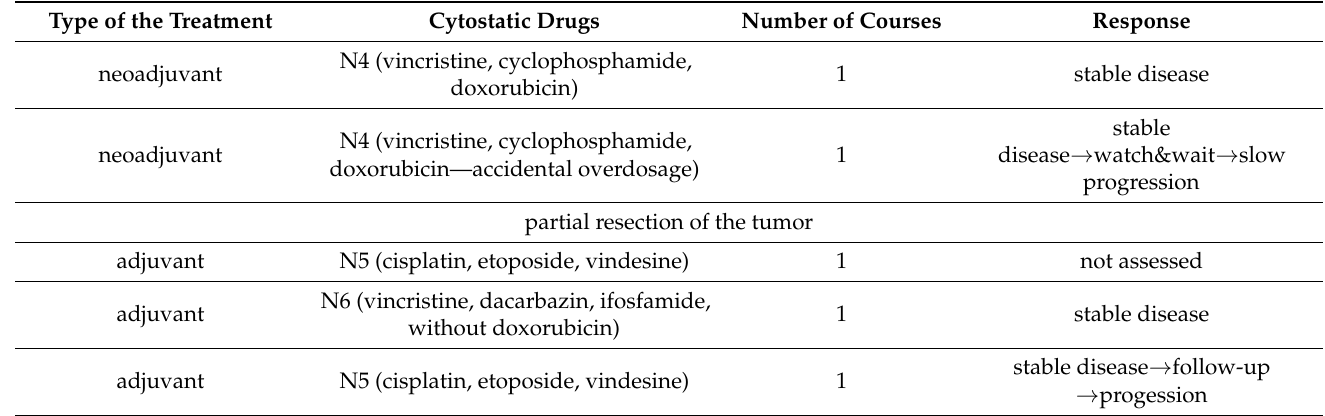
Table 3. Chemotherapy in patient 3.